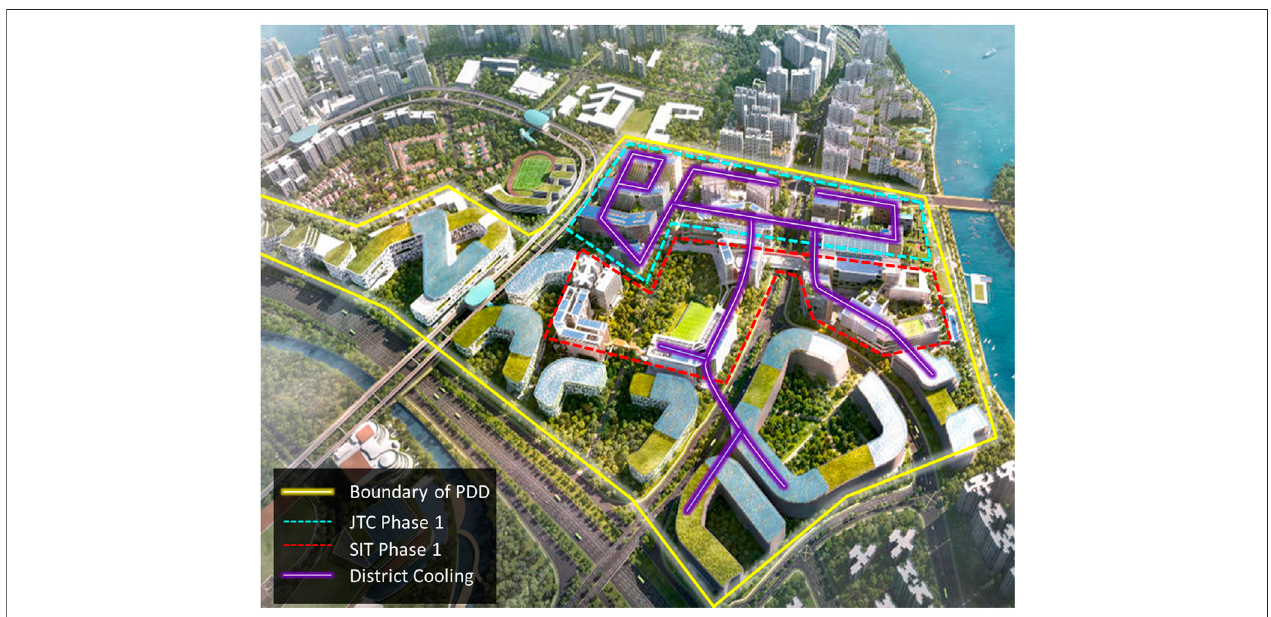
FIGURE 1 | Punggol Digital District planning area in